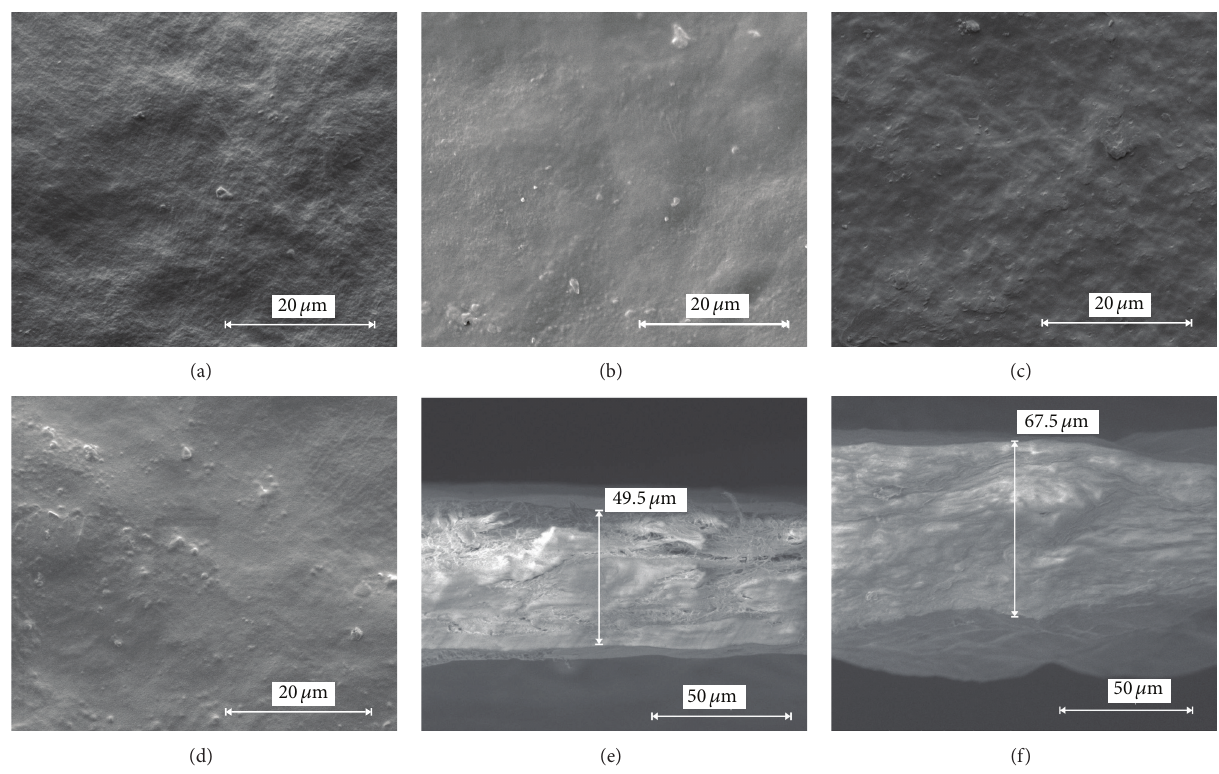
Figure 6: SEM images of MCCh:Fb = 1:1 composite membrane (M4). (a) Dry membrane surface— × 5000, (b) wet membrane surface – × 5000 and (c) dry cross-section— × 2000, (d) wet cross-section— ×